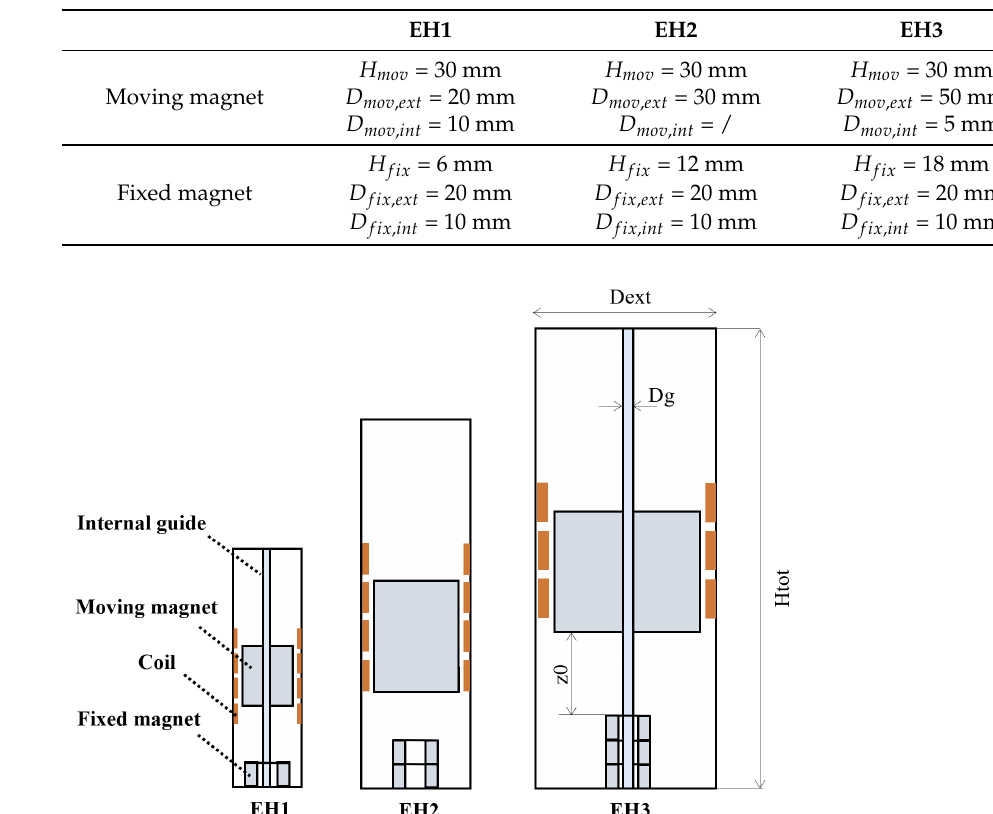
Table 2. Main dimensions of the magnets.